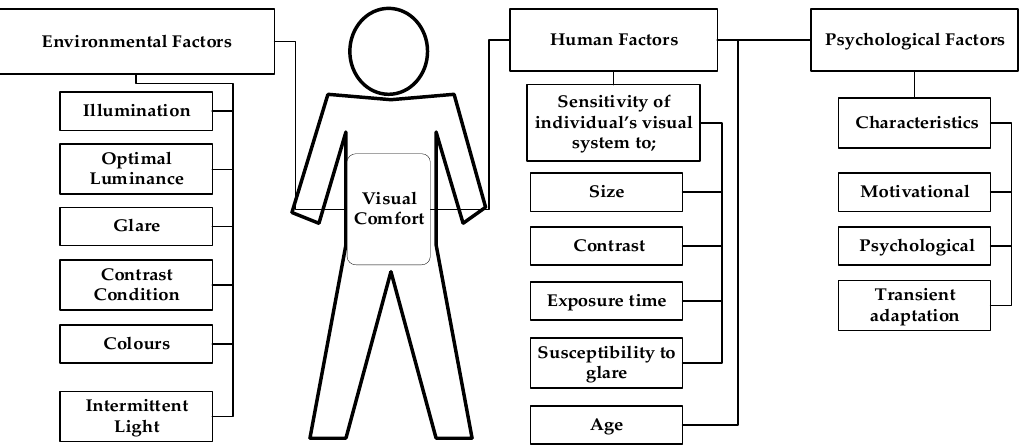
Figure 6. Categorization of different visual comfort factors [129,130].